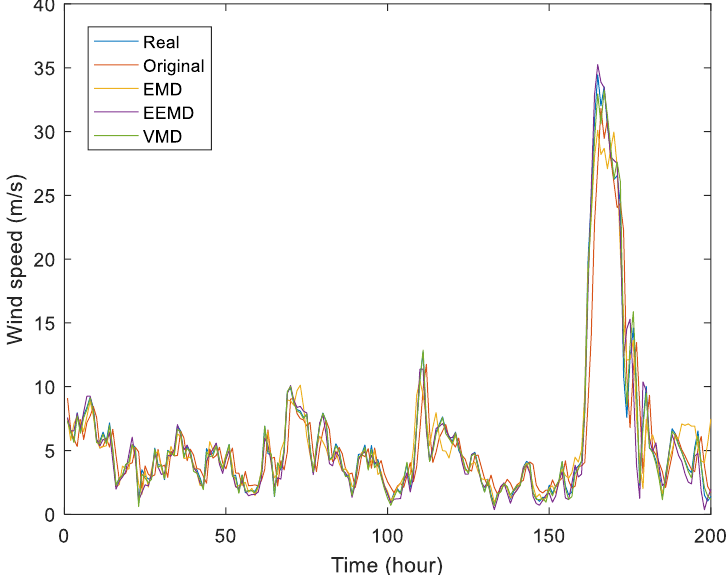
Figure 11. Predictions of different data processing methods.